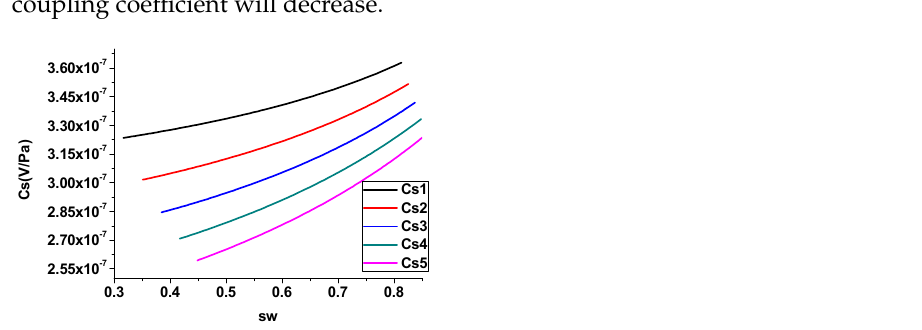
Figure 8. Variation of streaming potential coupling coefficient with saturation (slug flow). Figure 9 investigates the effect of water film thickness on the streaming potential coupling coefficient of the capillary under the condition of slug flow. The water film thickness is taken as 0.1 R , 0.12 R , 0.14 R , 0.16 R , and 0.18 R , respectively, R is the radius of the pore. It can be seen from the figure that with the increase in the water film thickness, the coupling coefficient gradually decreases. When the thickness of the water film increases, under the same water saturation, the length of the cylindrical part of the bubble will increase, resulting in the decrease in the effective streaming current in the pore, so the coupling coefficient will decrease.